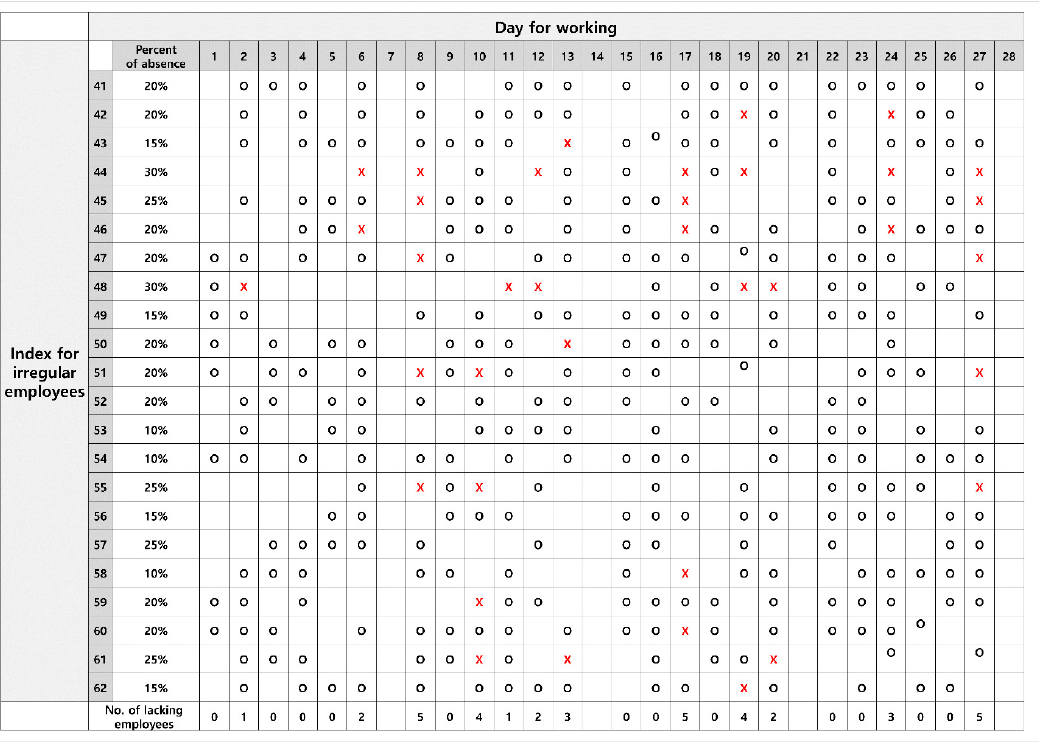
Figure 6. Result of simulation for evaluation of a staff schedule.